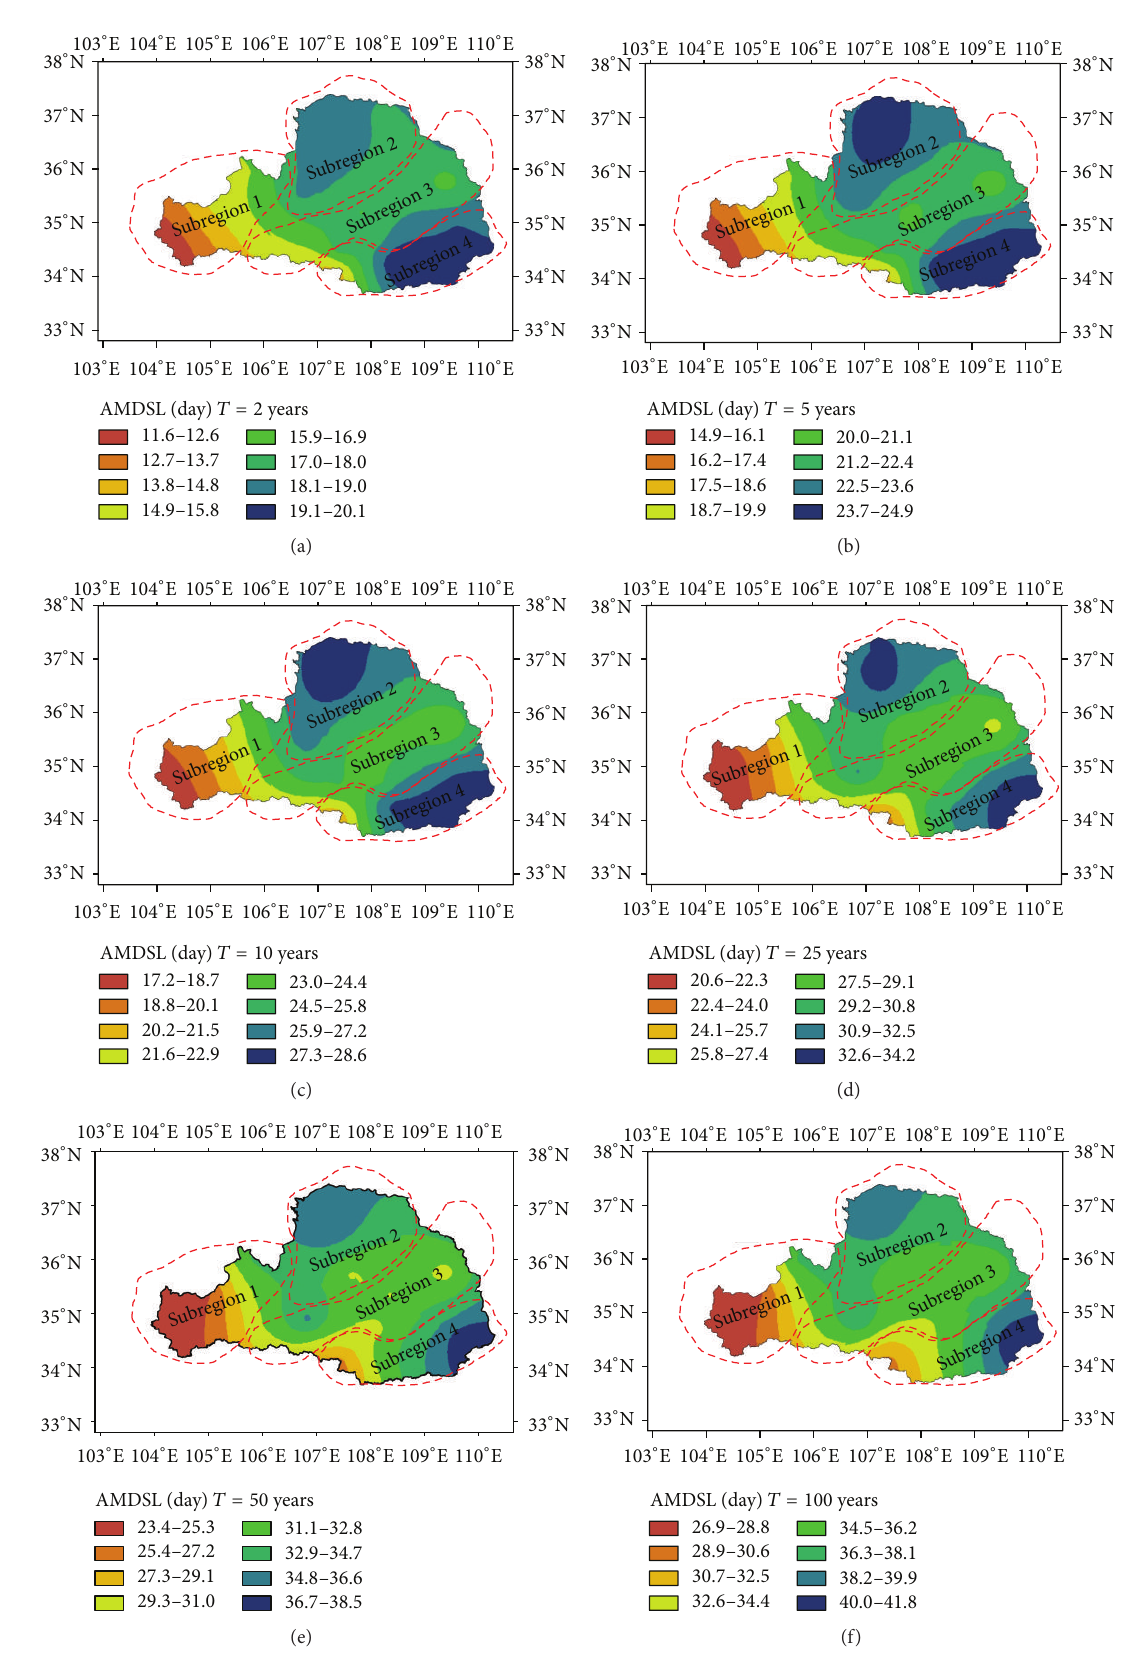
Figure 9: The spatial variations of quantiles of AMDSL with the return periods of (a) 2, (b) 5, (c) 10, (d) 25, (e) 50, and (f) 100